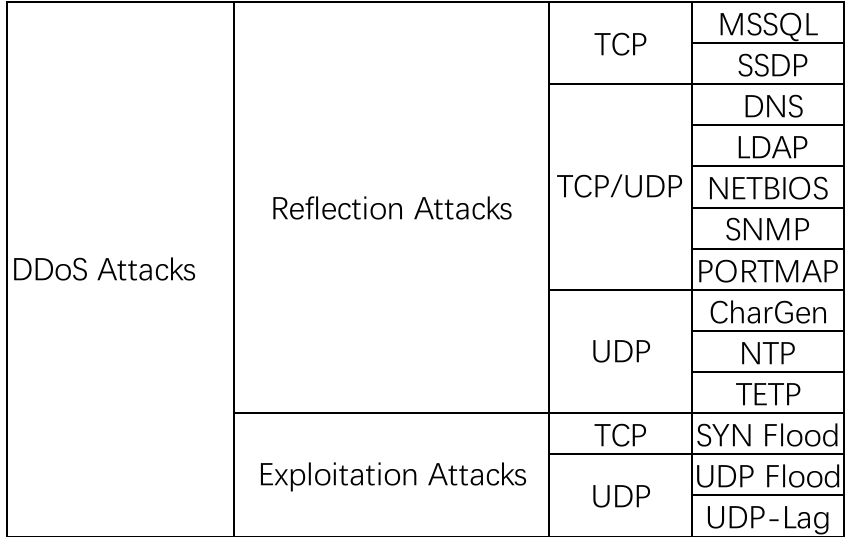
Figure 4. Detailed classification of DDoS attacks in CICDDoS2019.